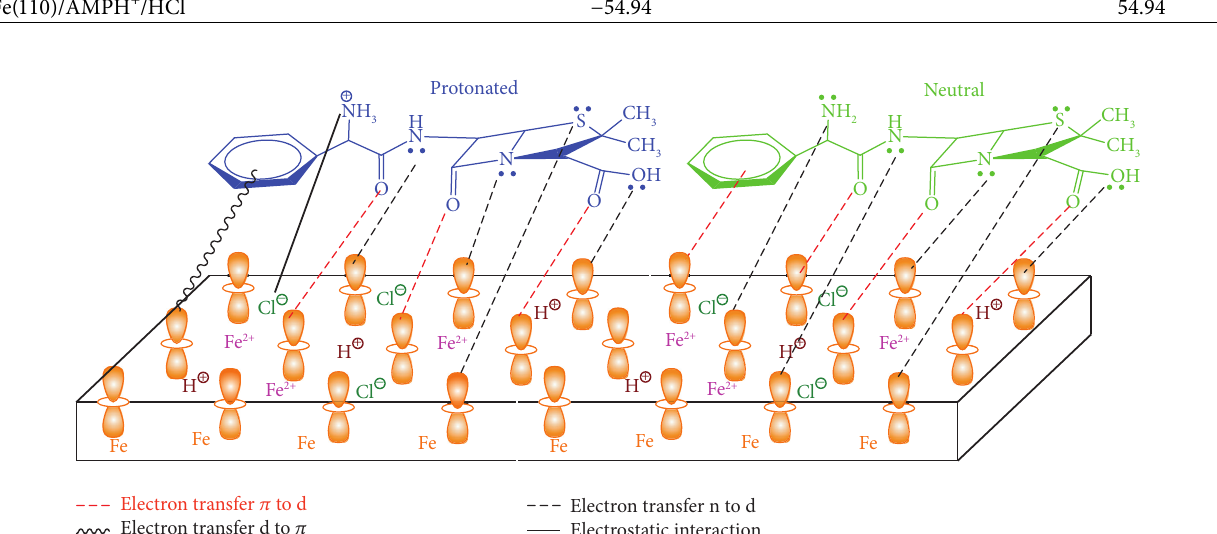
Figure 11: Top and side views for the interaction between neutral/protonated APM and surface mild steel in 1M HCl solution. Table 5: Interaction and binding energies of AMP and AMPH + on Fe(110) surface at 298K. System E Interaction (kcal/mol) E Binding (kcal/mol) Fe(110)/AMP/HCl